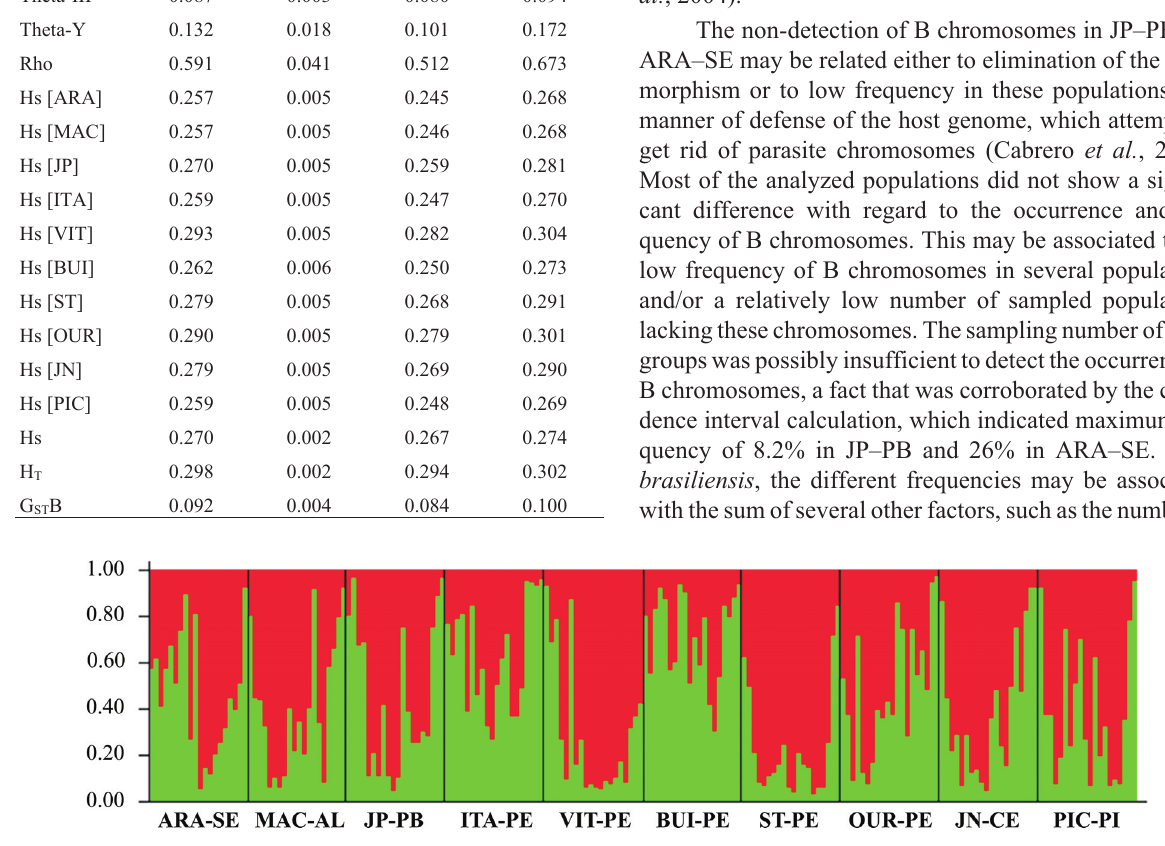
Figure 4 - Ancestry of Rhammatocerus brasiliensis specimens traced by the software Structure version 2.3.1, using seven ISSR primers and 95 polymor- phic bands. Each vertical bar corresponds to one of the 200 analyzed individuals and its population of origin. Bar length is proportional to parentage val- ues inferred in each group for each